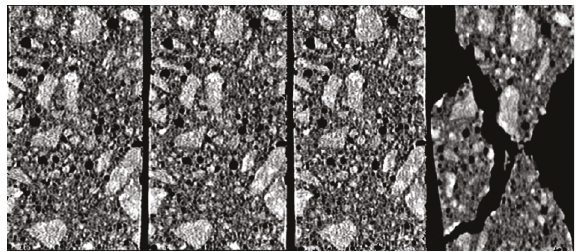
Figure 23: CT scan sectional drawings.